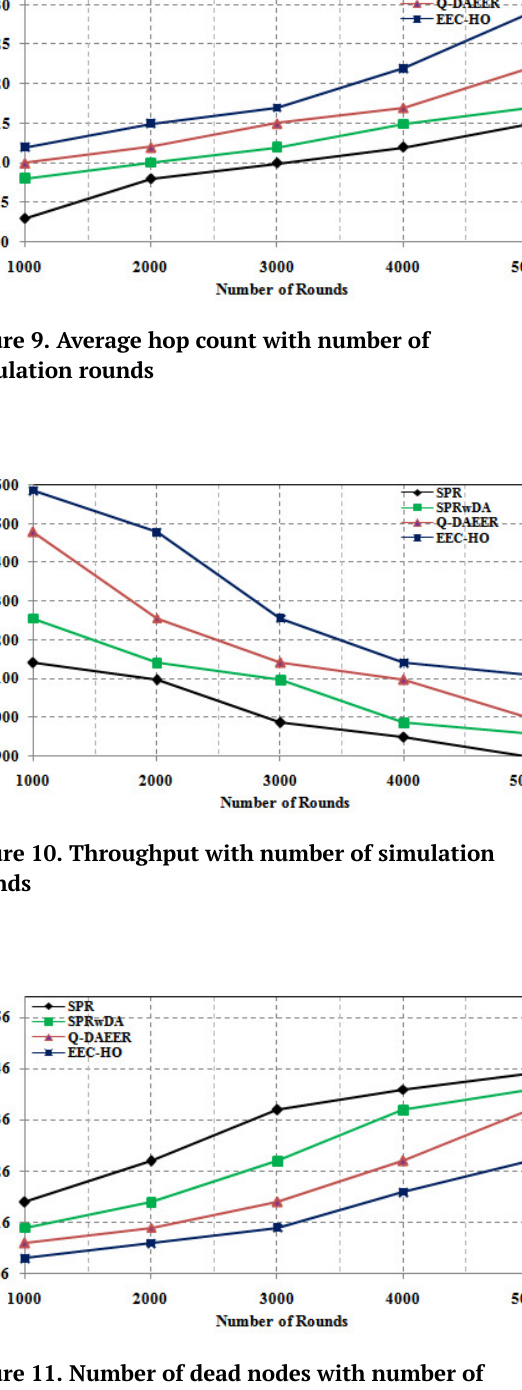
Figure 11. Number of dead nodes with number of simulation